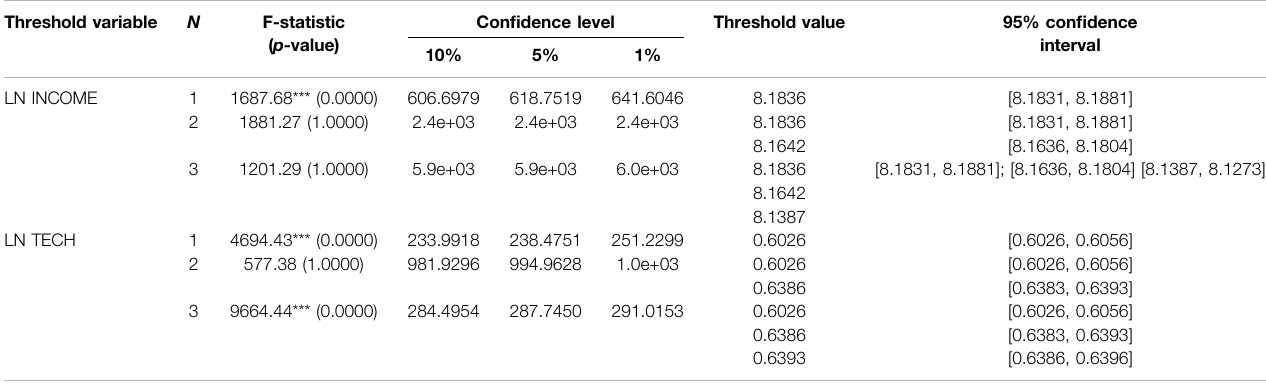
TABLE 6 | Threshold tests and con fi dence intervals for GDP per capita and carbon intensity Threshold variable